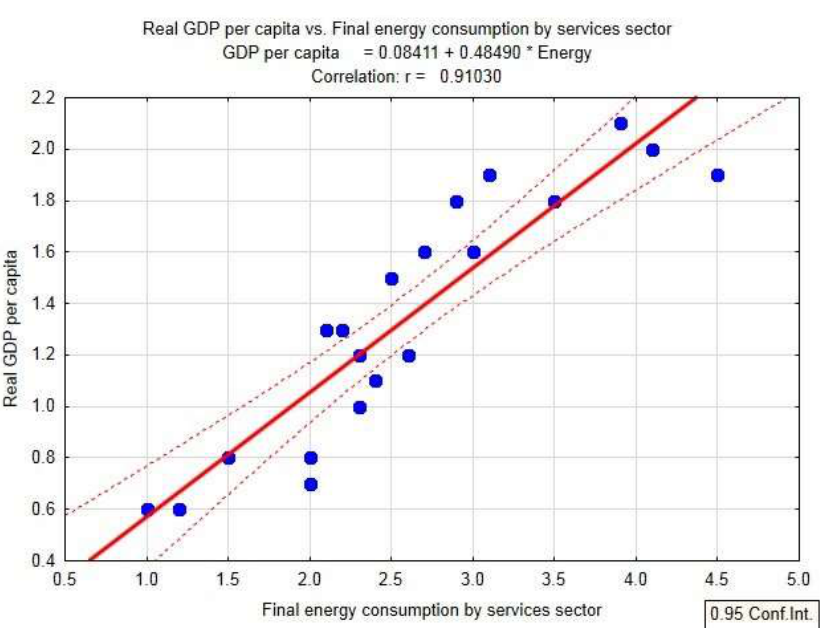
Figure 6. Linearized nonlinear regression verifying the impact of energy consumption on GDP growth. Source: Own elaboration based on the Statistica 13.3